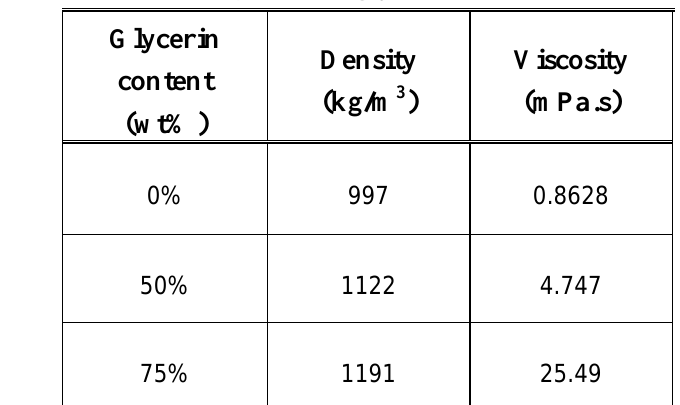
Table 2. Properties of glycerin-water solutions.